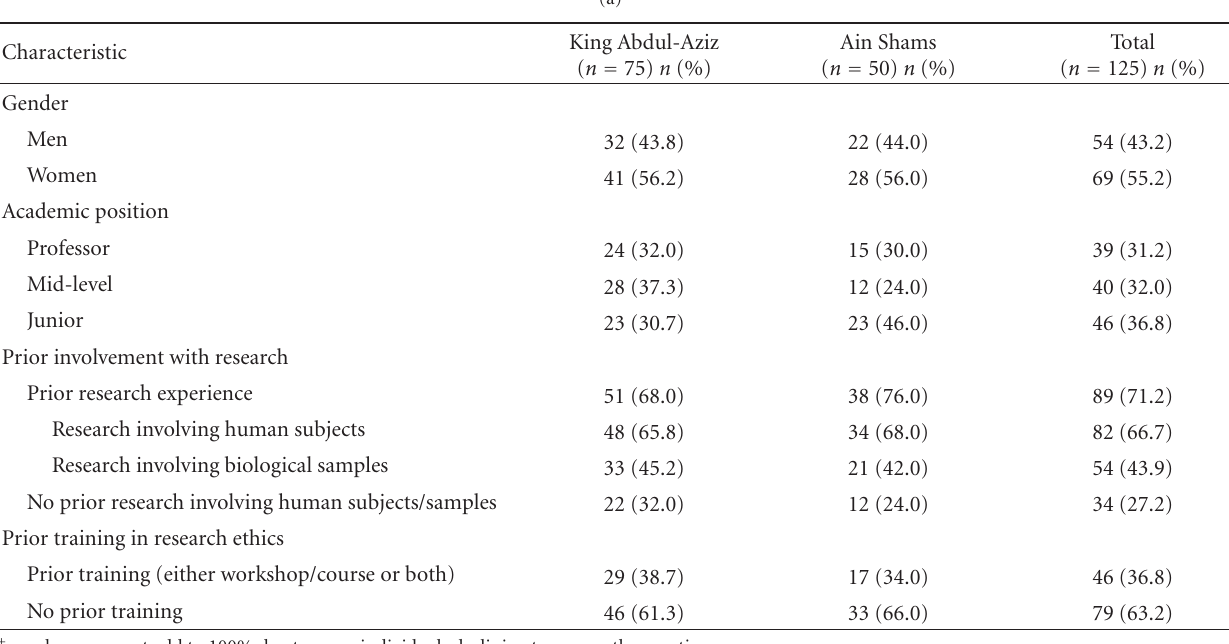
Table 1: Demographics of respondents from King Abdulaziz University and Ain Shams University + . Association of gender and academic position with prior research experience and prior ethics training ( n =